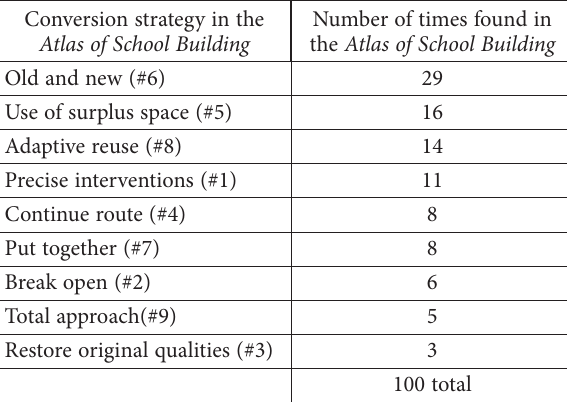
Figure 2. Nine typical examples of conversion